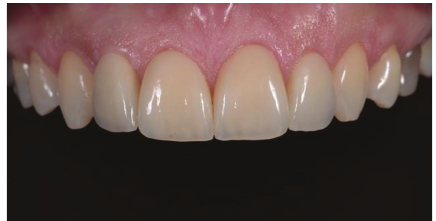
Table 6: Appreciation of the previsualization with VAS scale.